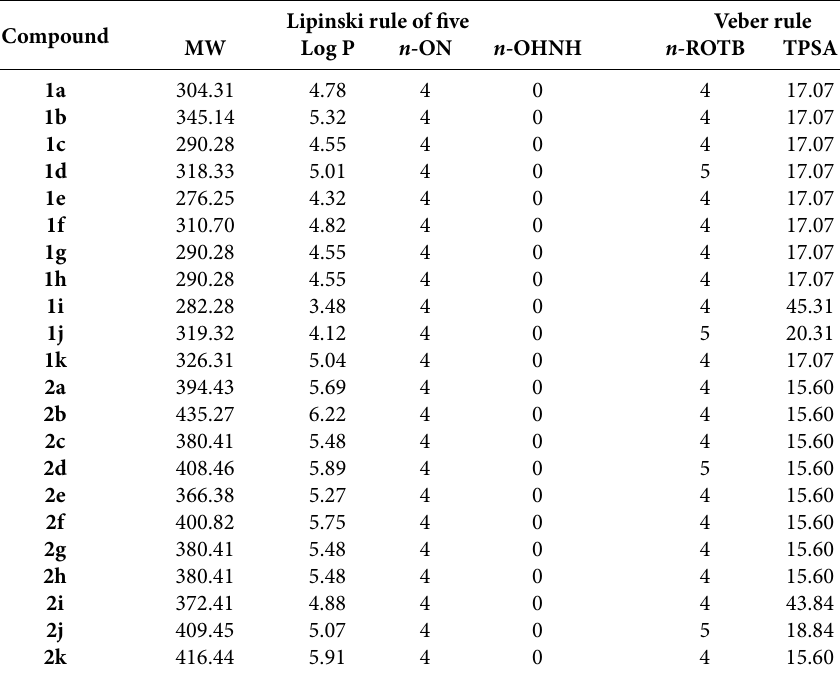
Table 2 . Predicted ADME, Lipinski and Veber parameters of the synthesized